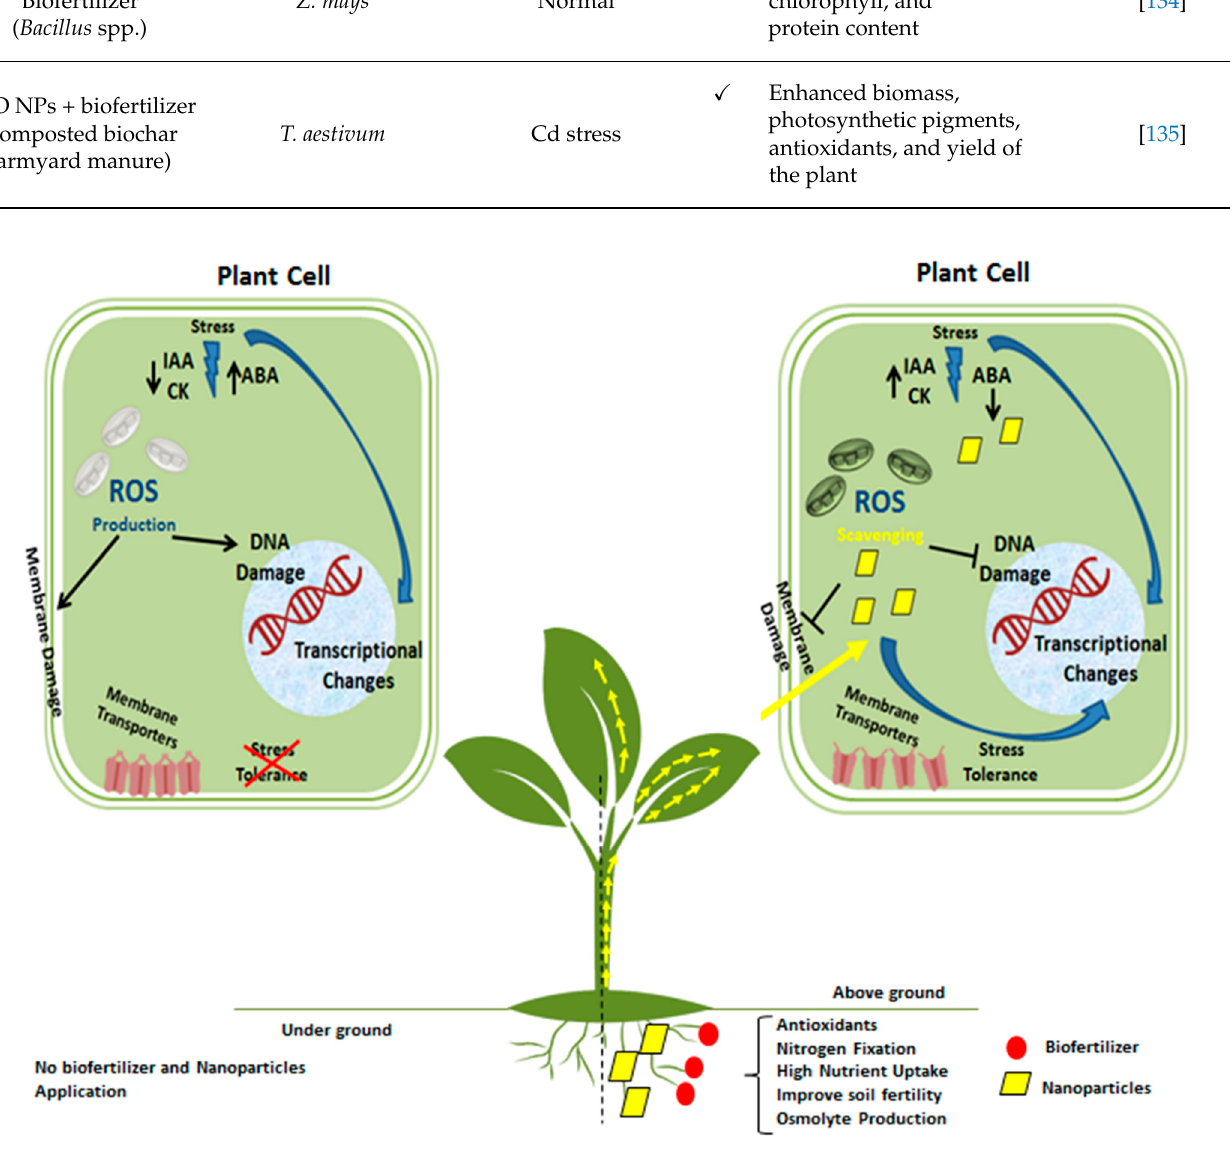
Figure 4. Role of nanobiofertilizer on the plant under stress. Under stress conditions, reactive oxygen species (ROS) are produced that damage the plant cell organs. The application of nanobiofertilizers aids in nitrogen fixation, nutrient solubilization, improved soil fertility, and the production of antioxidants and osmolytes. These antioxidants and osmolytes help the plant to scavenge ROSs. Table 2. Role of nanobiofertilizer in different plants under control and stressed conditions. The application of nanobiofertilizer increases the number of grains per comb, the number of rows per comb, grain yield, and biomass yield and improves the harvest index of Z. mays in a limited water supply [136]. The use of gold nanoparticles accelerates the performance of Bacillus subtilis (33%), Pseudomonas fluorescens (57%), and P. elgii . They also improve the plant’s growth when used in the formulation of nanobiofertilizer [137]. It has been observed that biofertilizer (PGPR) controls the availability of nutrients in the soil, including nanoparticles. An experiment was designed to evaluate the role of nanoparticles on S. lycopersicum with and without Azotobacter salinestris inoculation. Azotobacter